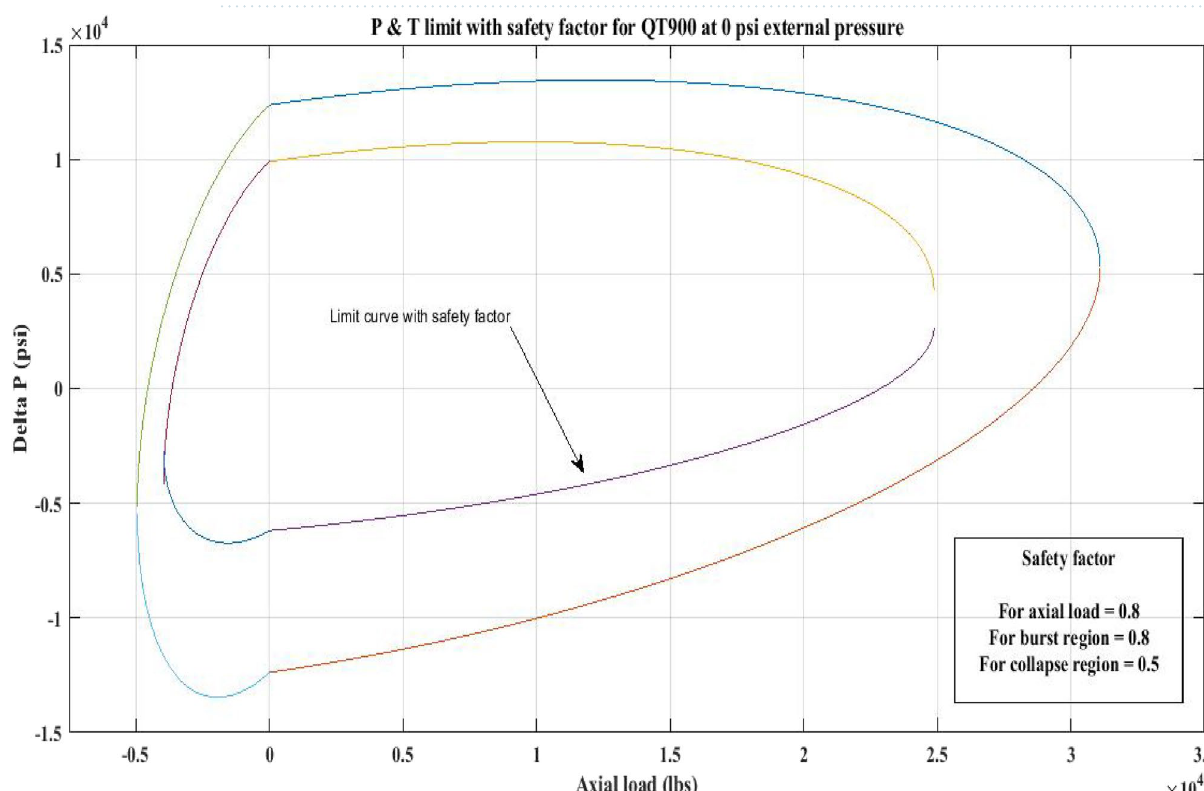
Figure 19. P and T limit with safety factor for QT 900 at 0 P o